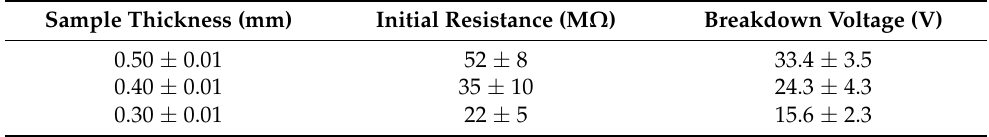
Table 3. Dependence of the initial resistance and breakdown voltage to the thickness of the granular medium for the raw powder. Each measurement was repeated five